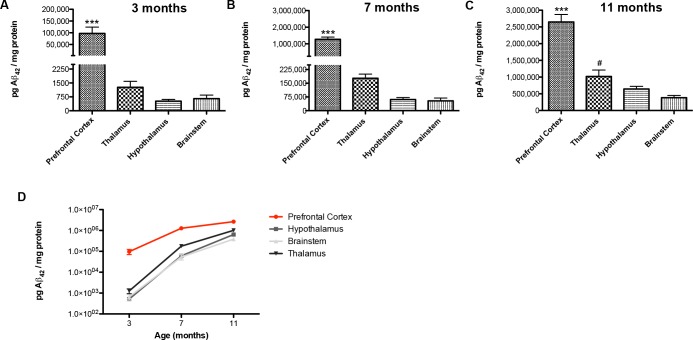
Quantification of Aβ42 levels from key regions regulating the sleep-wake cycle.Quantification of total Aβ42 levels from the prefrontal cortex, hypothalamus, thalamus and brainstem of 3 (n = 7), 7 (n = 9) and 11-month-old (n = 7) TgCRND8 mice. Picograms (pg) of total Aβ42 are normalized to milligrams (mg) of protein per sample. (A, B and C) At 3, 7 and 11 months of age the prefrontal cortex contains the highest level of total Aβ42, differing significantly from the hypothalamus, thalamus and brainstem. (C) At 11 months of age, the thalamus contains significantly higher total Aβ42 than the brainstem. (D) Progression of total Aβ42 overexpression in the prefrontal cortex, hypothalamus, thalamus and brainstem at 3, 7 and 11 months of age. Error bars represent SEM. Fig 4A, 4B and 4C were analyzed by one-way ANOVA for the effect of brain region at a given age, followed by Tukey’s post-hoc. * Denotes a significant difference between the prefrontal cortex and each other region. # Denotes a significant difference between the thalamus and the brainstem. */#
P<0.05, ** P<0.01, *** P<0.001.